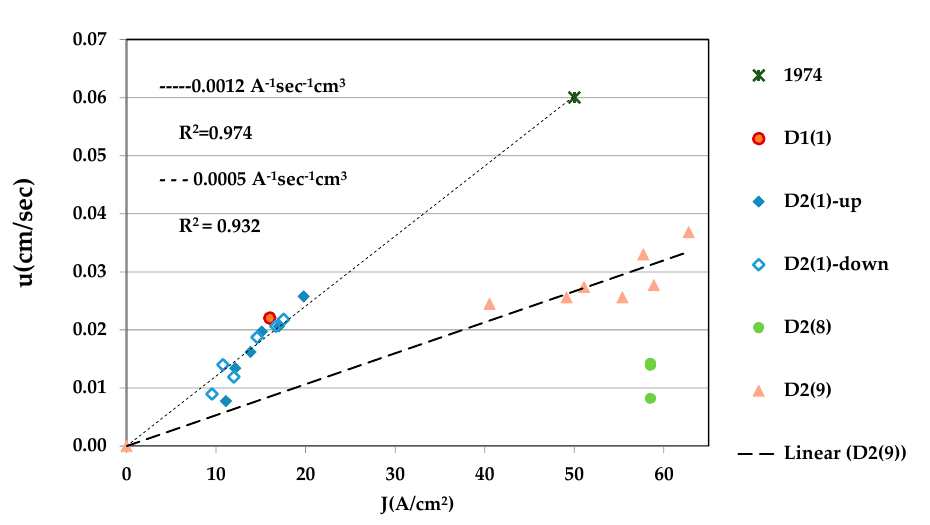
Figure 7. Sliding velocity as function of current density in samples of VO 2 .